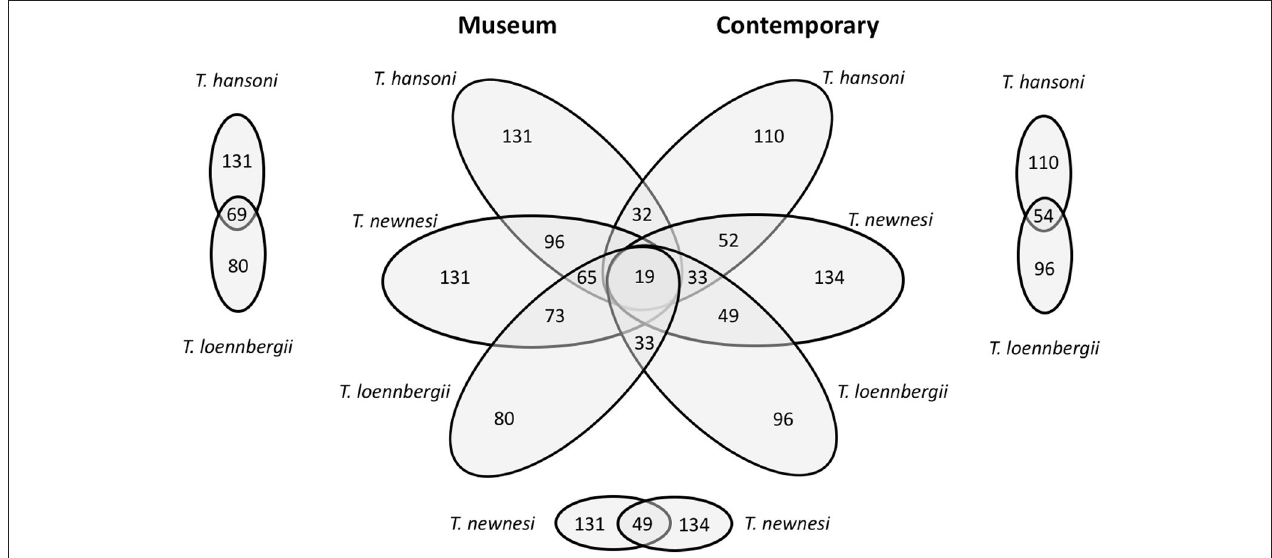
FIGURE 5 | Six-way Venn diagram of the microbial OTU composition in the guts of members of the genus Trematomus ( T. hansoni, T. newnesi, T. loennbergii ) from museum and contemporary samples.